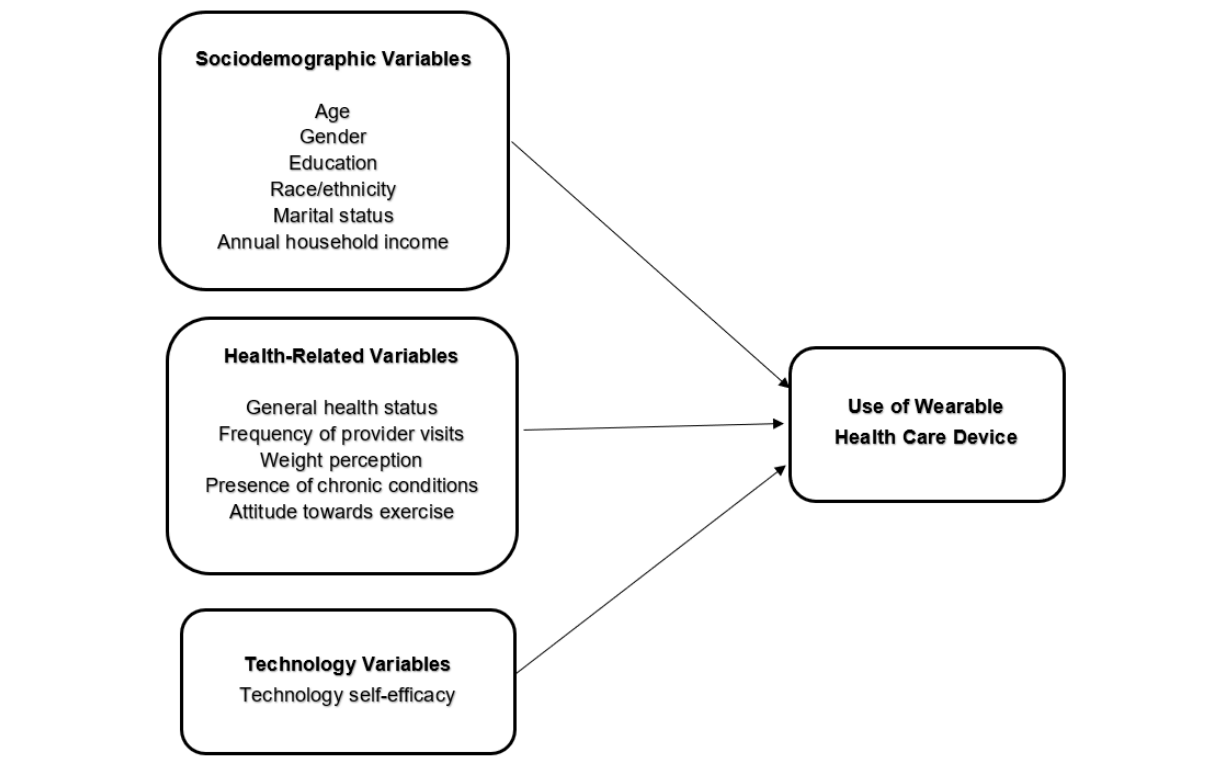
Figure 1. Research model with key predictors of wearable health care device